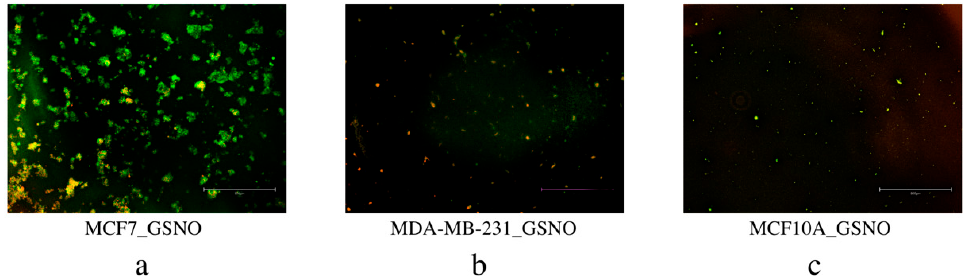
Figure 12. Detection of apoptosis in MCF7 ( a ), MDA-MB-231 ( b ), and MCF10A ( c ) cells by Annexin V/FITC and PI staining. Cells were treated with NO (Group 1) for 24 h, stained with Annexin V/FITC (green) and PI (red), and then imaged with fluorescence microscopy.